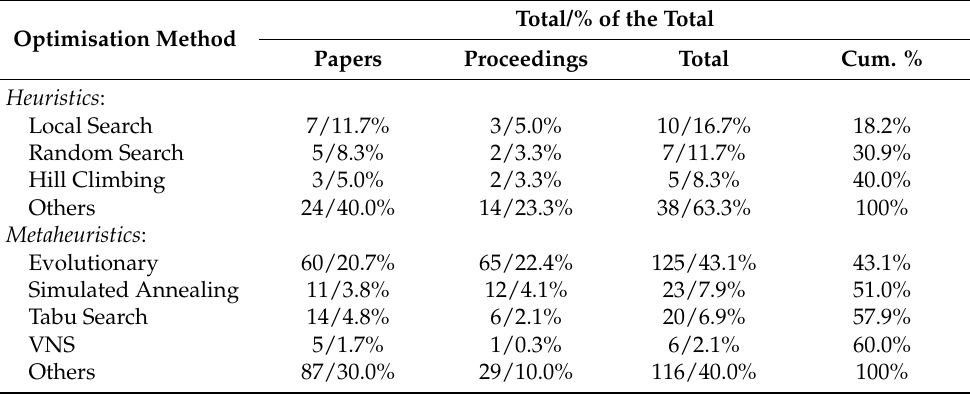
Table 1. DSBO methods used